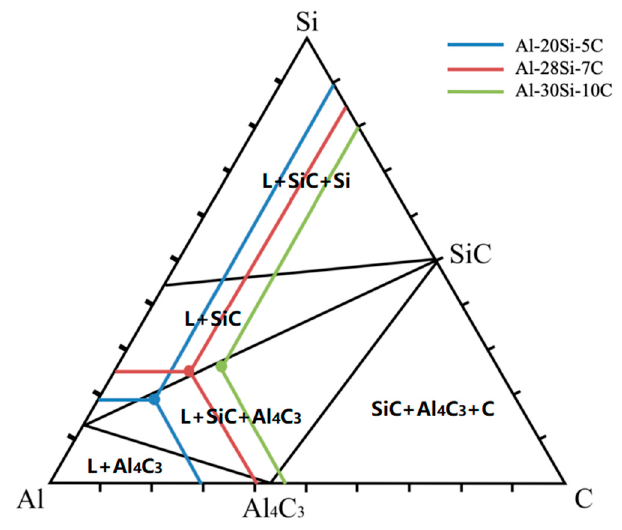
Figure 3. Distribution of the different component ratios of composites (Al-20Si-5C, Al-28Si-7C, Al-30Si-10C, wt%) in the Al-Si-C ternary phase diagram at 1000 °C [26].